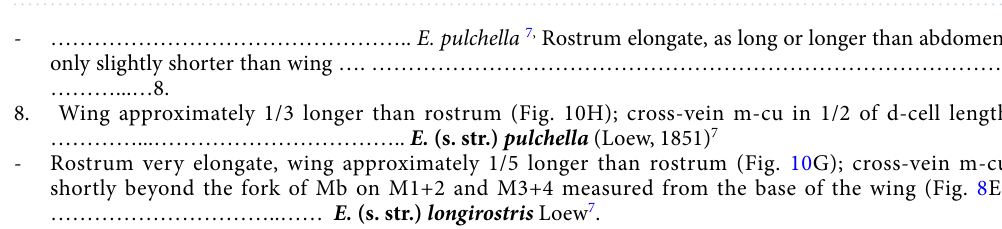
Figure 10. Relation between the length of wing (w), rostrum (r) and abdomen (ab) in different fossil species of Elephantomyia : ( A ) Elephantomyia (s. str.) grata , ( B ) Elephantomyia (s. str.) baltica , ( C ) Elephantomyia (s. str.) bozenae , ( D ) Elephantomyia (s. str.) brevipalpa , ( E ) Elephantomyia (s. str.) christelae sp. nov., ( F ) Elephantomyia (s. str.) irinae , ( G ) Elephantomyia (s. str.) longirostris , ( H ) Elephantomyia (s. str.) pulchella , ( I ) Elephantomyia (Hoffeinsonia) prima subgen. et sp.